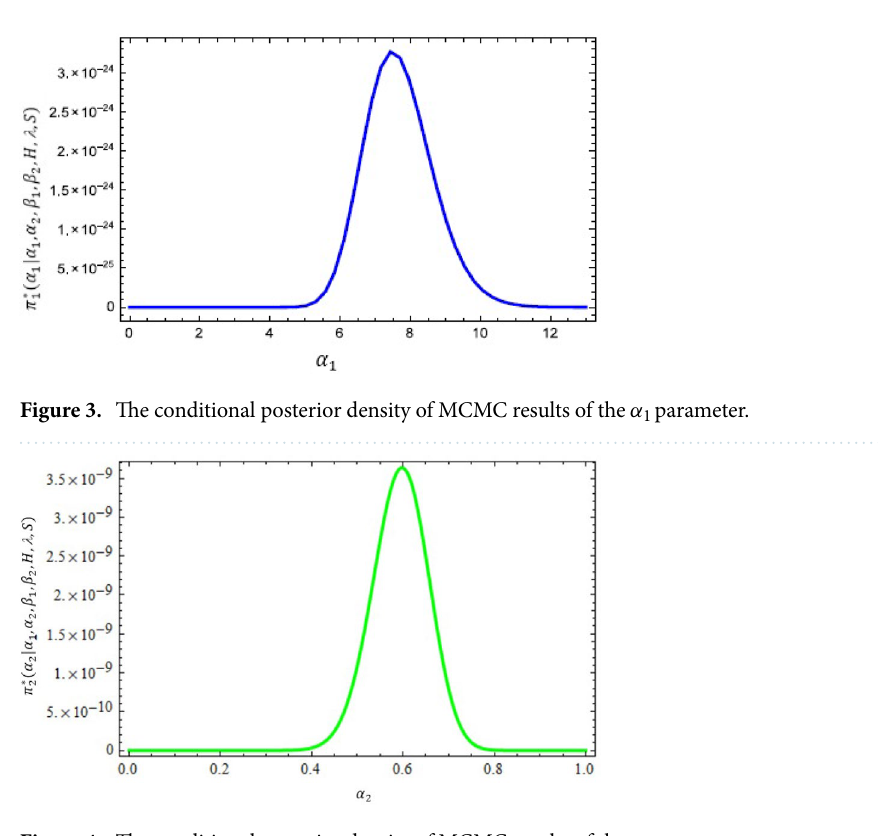
Figure 4. The conditional posterior density of MCMC results of the α 2